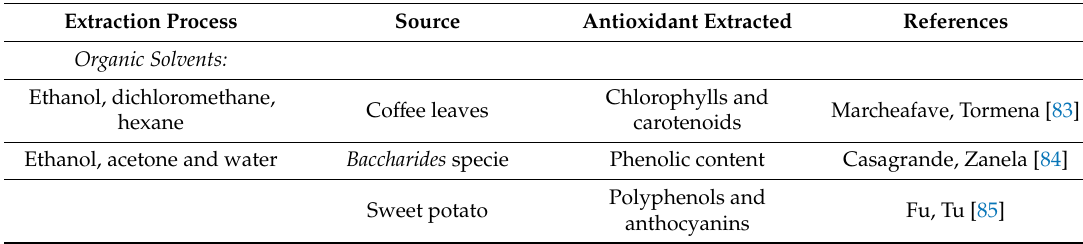
Table 3. Methods for antioxidants’ extraction from natural